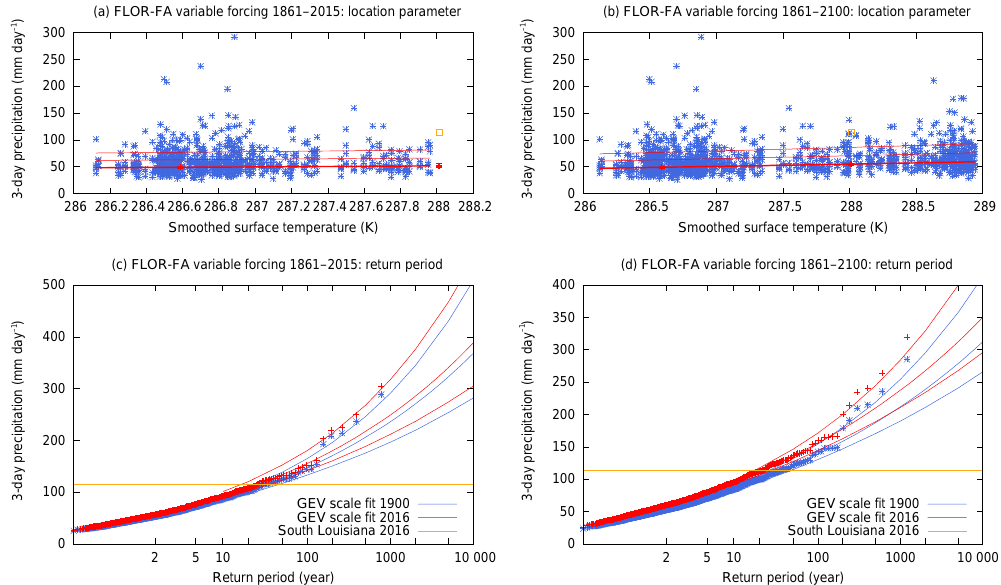
Figure 12. The same as Fig. 4 but for the annual and spatial maximum 3-day average precipitation in the FLOR-FA variable forcing experiment, with (a, c) taking into account years 1861–2015 and (b, d) taking into account